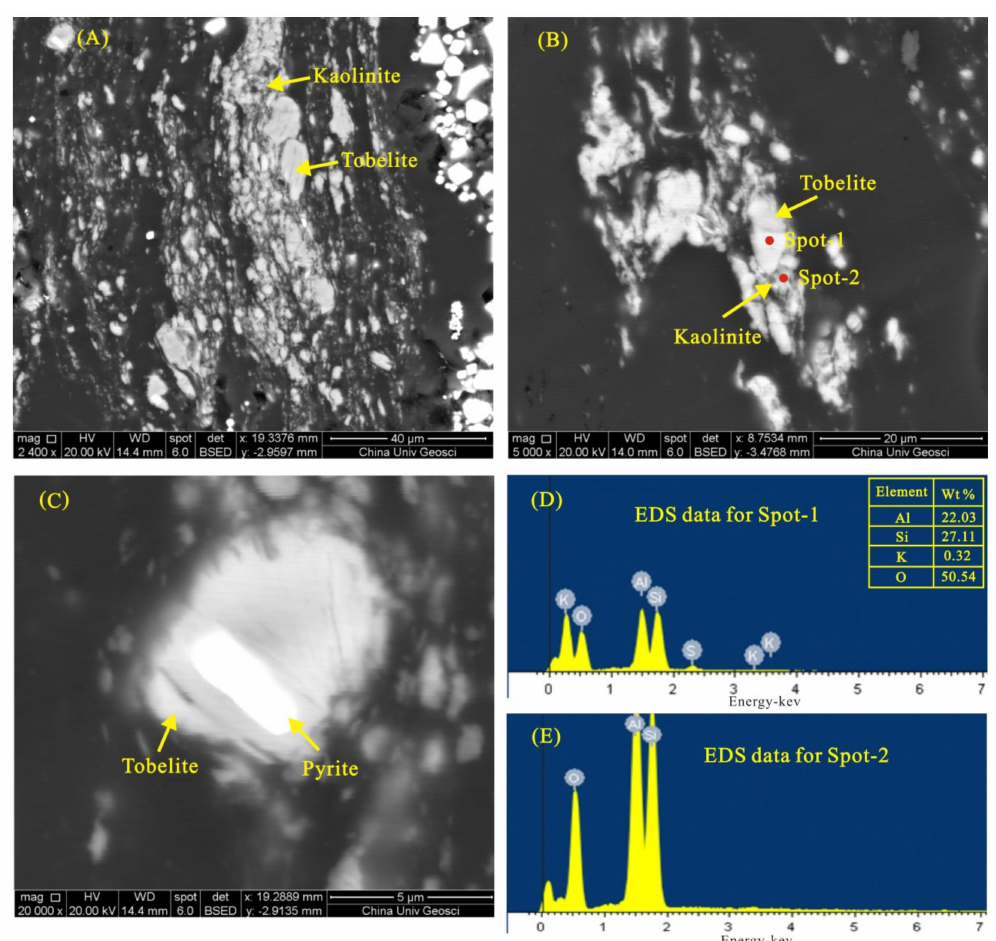
Figure 8. SEM back-scattered electron images of minerals in the coal sample (sample CLB4-12) and EDS analysis of selected minerals. ( A ): dispersed kaolinite and tobelite particles along bedding planes; ( B ): pore space-filling tobelite; ( C ): pore space-filling tobelite containing an inclusion of pyrite; ( D ): EDS spectra of tobelite containing trace K; ( E ): EDS spectra of